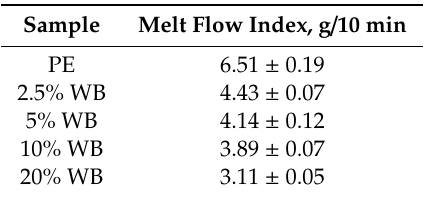
Table 3. Melt flow index (MFI) of PE-WB